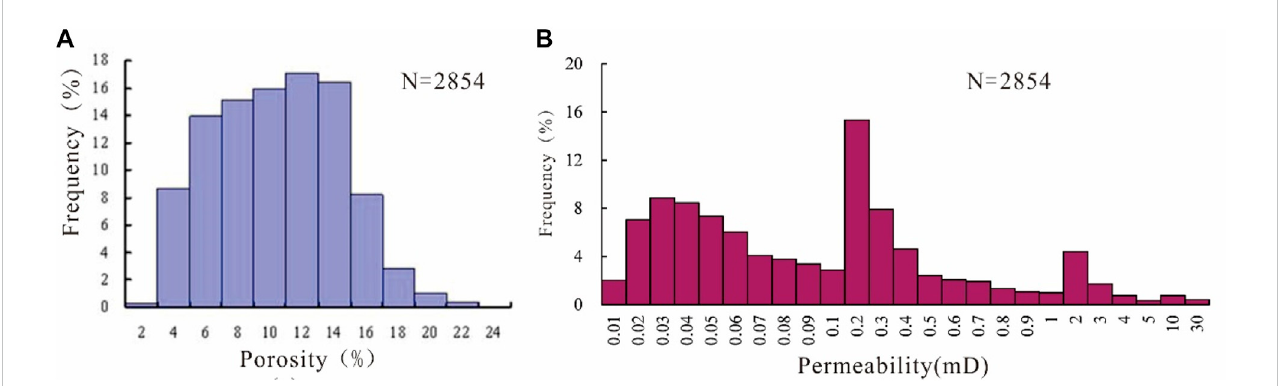
FIGURE 3 Frequency distribution characteristics of the (A) porosity and (B) permeability of the Gaotaizi reservoir in the Qijia area.